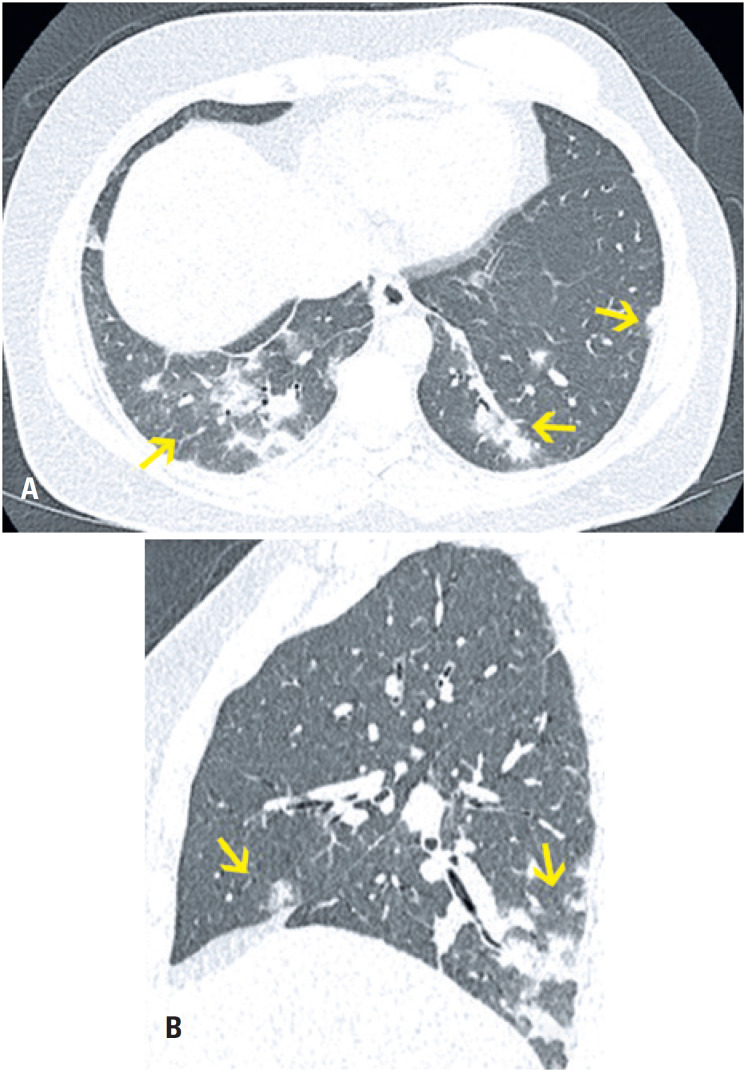
Paciente do sexo feminino, 47 anos, com queixa de tosse produtiva e mialgia. Tomografia computadorizada (A) Axial (B) Reformatação sagital: micronódulos e opacidades em vidro fosco em ambos os pulmões, principalmente nos lobos inferiores, onde confluem em focos de consolidação alveolar, algumas com aspecto grosseiramente nodular. A proteína C-reativa respiratório positivo para vírus da influenza